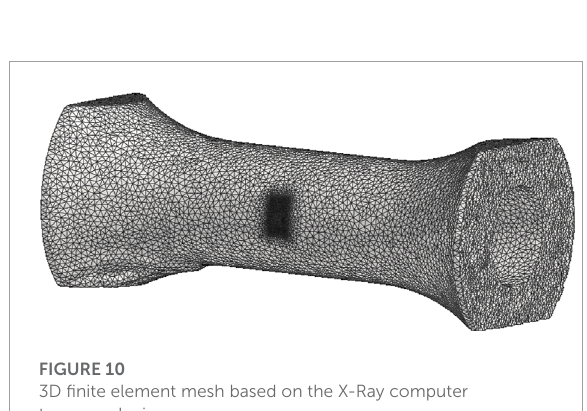
FIGURE 9 X-Ray computer tomography image of the mechanical specimen.